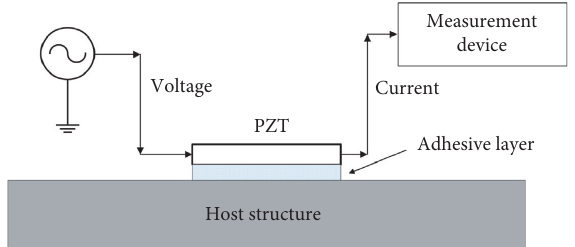
Figure 1: Detection schematic diagram of PZT coupled with the host